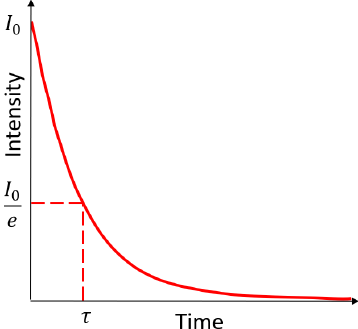
Figure 2. Illustration of the phase shift and the amplitude attenua-